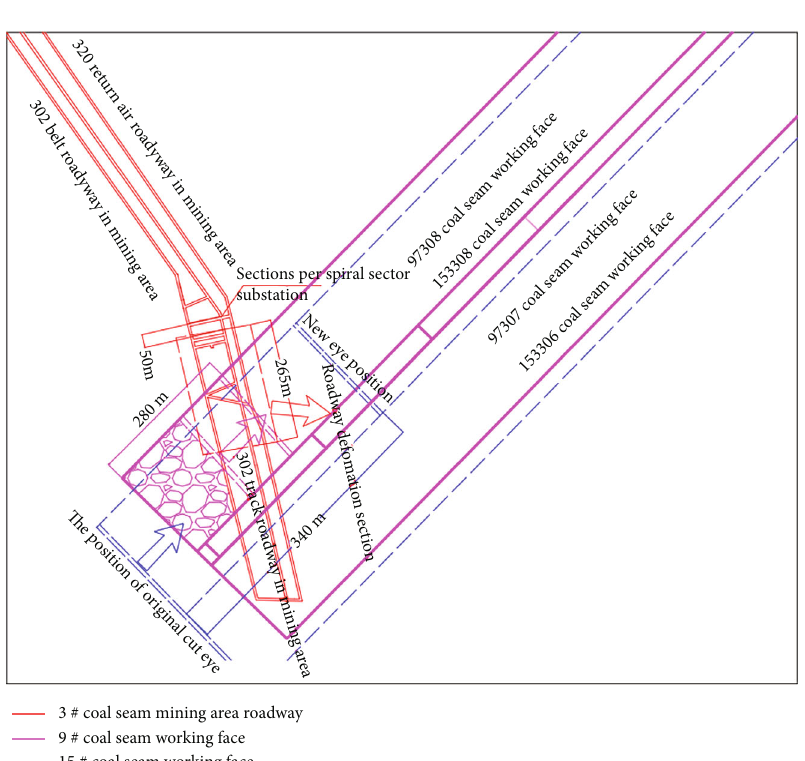
Figure 2: Spatial relationship diagram of roadway and underlying coal seam in 302 mining